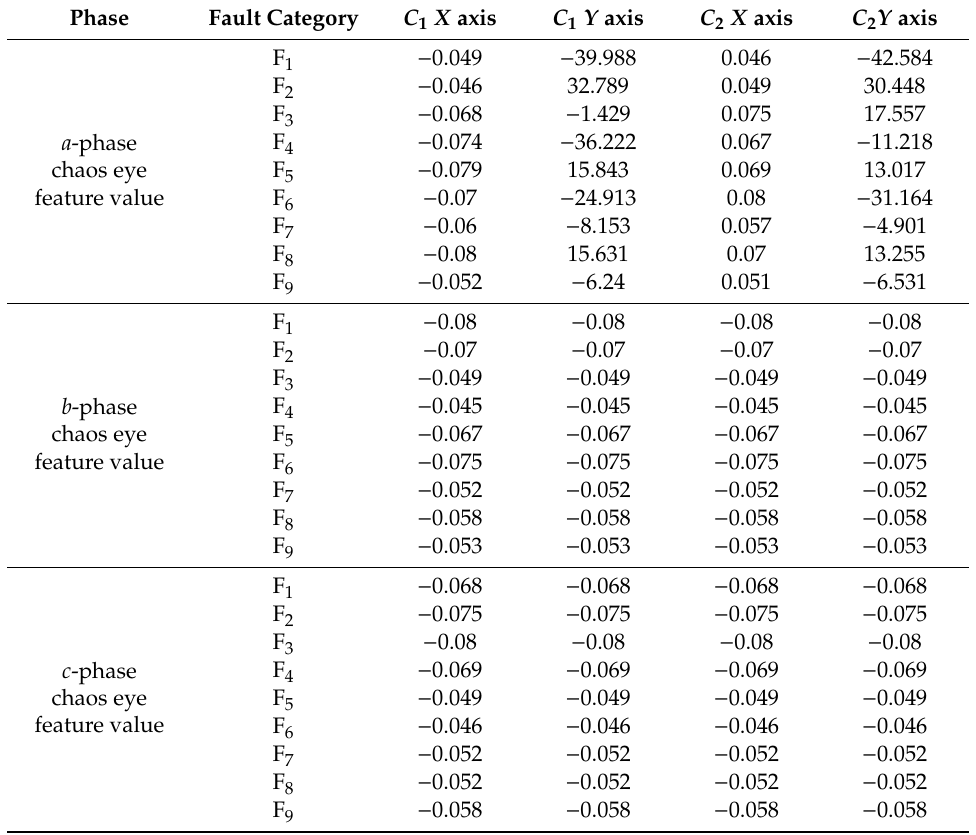
Table 2. Feature values of chaos eyes under various fault states (inverter frequency = 60